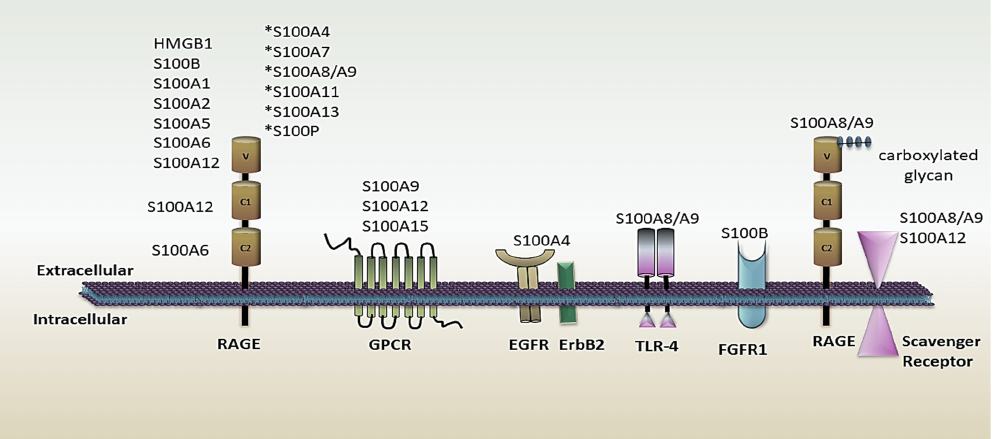
Figure 1. S100 isoforms interact with a range of cell surface receptors, such as GPCR, RAGE, TLR-4, and proteoglycans heparin sulphate and N glycan scavenger receptors. GPCR, G protein-coupled receptors; RAGE, Receptor for Advanced Glycation End-Products; TLR-4, Toll-Like Receptor-4. * S100A4, S100A7, S100A8/A9, S100A11, S100A13, and S100P interact with and/or activate RAGE, but the exact domain is unknown.